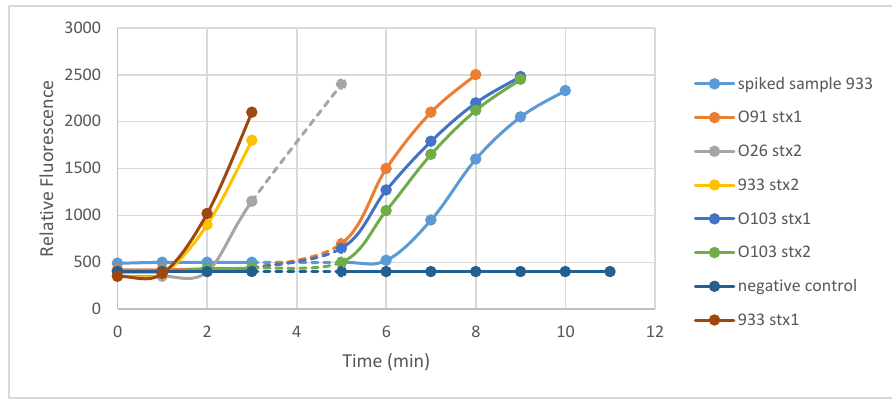
Figure 1. 1D plot of the recombinase polymerase amplification (RPA) reactions. Four organisms were tested in each RPA, and were run in separate channels for stx 1 and stx 2, respectively. Shiga toxin- producing E. coli (STEC) strain O157:H7 EDL933 was positive for stx 1 and 2, E. coli O26:H11 was positive for stx 2, E. coli O103:H2 was positive for stx 1 and 2, E. coli O91:H21 was positive for stx 1, and the flat line is the negative control. There is a dashed line in the data at around 4 min, where the samples were removed from the system to be agitated and then reintroduced back into the system right after. Positive results are observed by an exponential increase of fluorescence and negative results are observed by no increase or flat line.